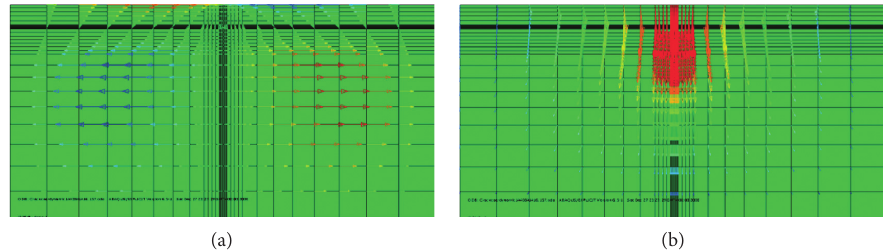
Figure 24: Development trend of a periodic displacement. (a) Horizontal displacement. (b) Vertical displacement.